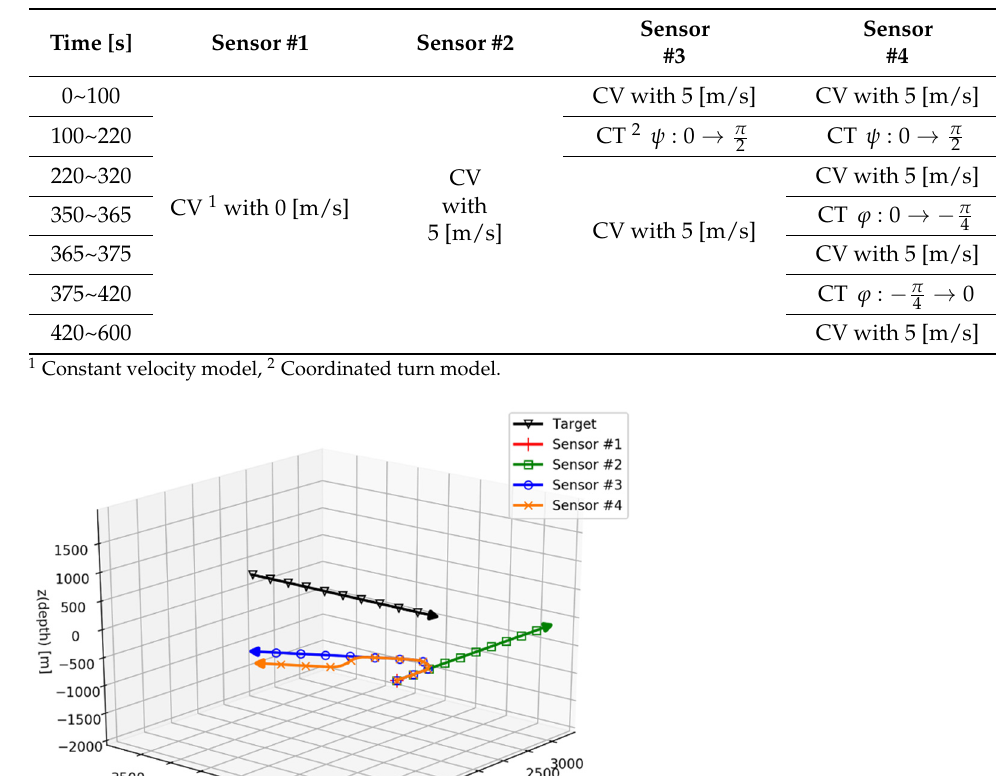
Table 1. Sensor maneuvering scenario.